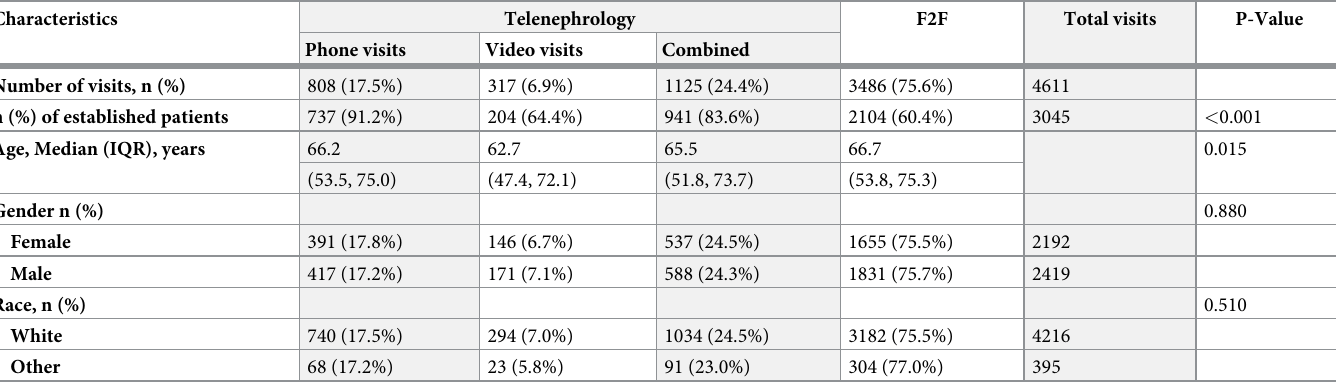
Table 1. Study cohort patients’ characteristics (March, 2020 –July, 2020).